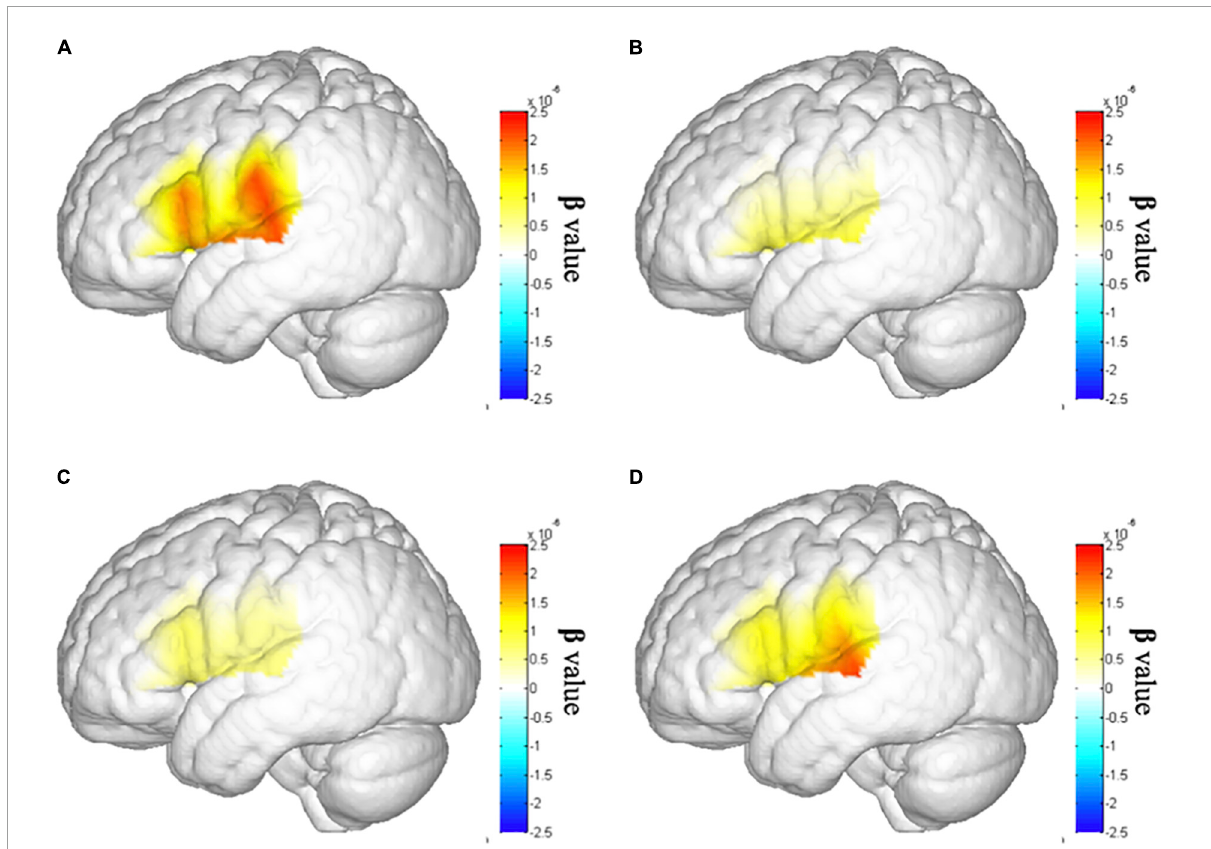
FIGURE6 Brain activation map of the left superior temporal cortex (lSTC). (A) Brain activation map of lSTC in the healthy individual group. (B) Brain activation map of lSTC in the stroke group before tDCS. (C) Brain activation map of lSTC in the stroke group after seven times tDCS. (D) Brain activation map of lSTC in the stroke group after 14 times